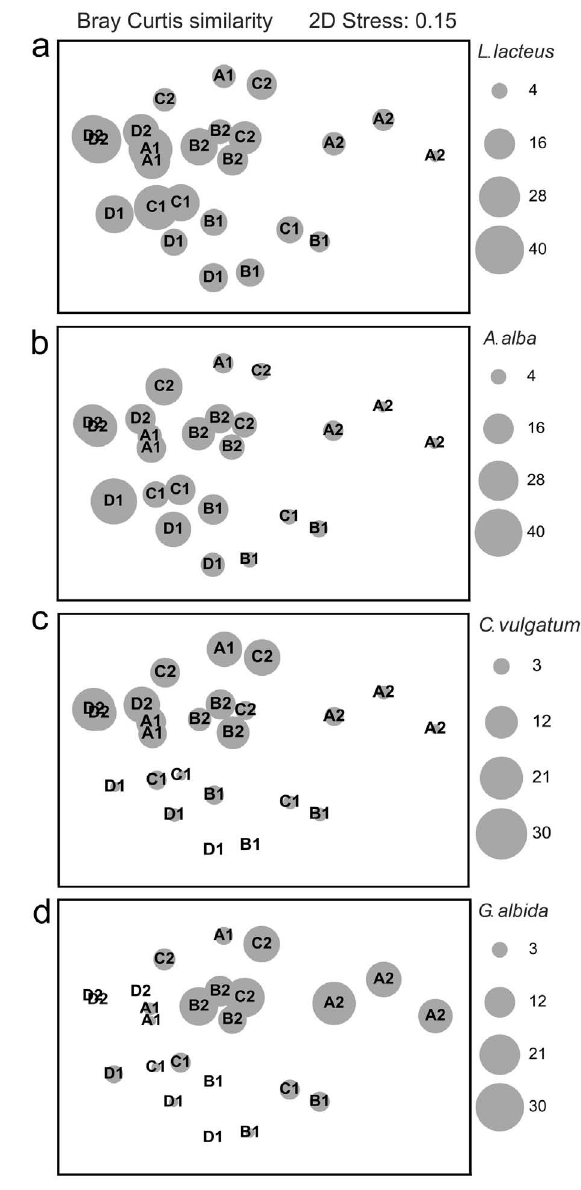
Fig . 5. – nMDS ordination of the mollusc assemblages in July (A1, B1, C1, D1) and January (A2, B2, C2, D2). The abundances of Loripes lacteus (a), Abra alba (b), Cerithium vulgatum (c) and Gibbula albida (d) are superimposed on the ordination plots. The diameter of bubbles is proportional to the number of individuals per replicate.